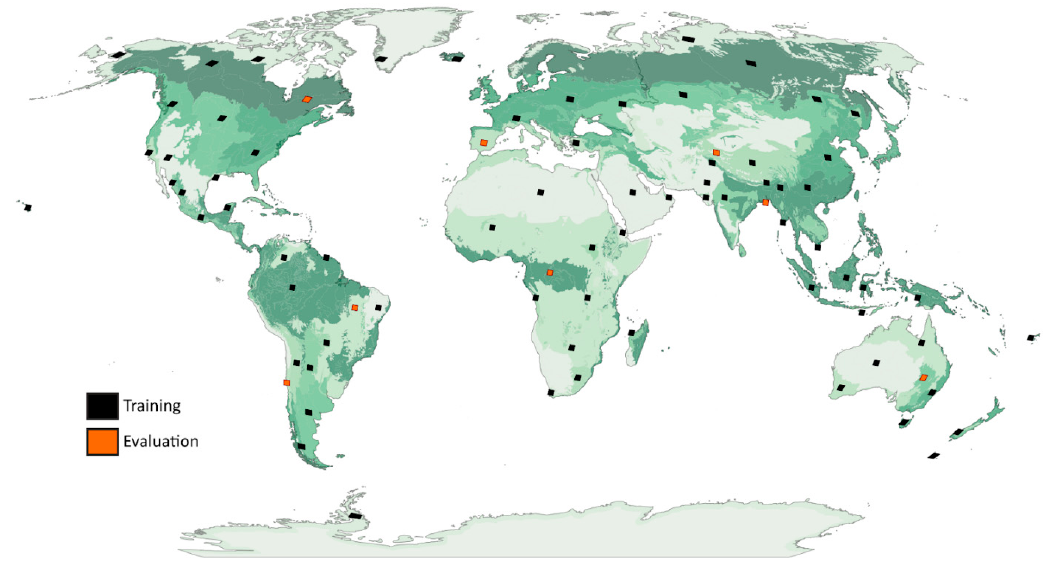
Figure 1. Locations were selected by identifying one path / row from each of the 14 World Wildlife Fund terrestrial Major Habitat Types plus ‘Inland Water’ and ‘Rock and Ice’ (these 16 types represented in shades of green) for each of the seven biogeographical realms, plus an additional scene from each habitat type chosen at random. Not all combinations occur; a total of 80 scenes were selected and split into 72 used during training (black) and eight used during evaluation (orange). To facilitate manual labeling, false-color images were generated by mapping the shortwave-infrared-1 band (B6) to red, the near-infrared band (B5) to green, and the red band (B4) to blue. A single interpreter labeled each pixel based only on visual interpretation using Photoshop; no thresholding, clustering, or other automated/mathematical approaches were used to assist labeling.